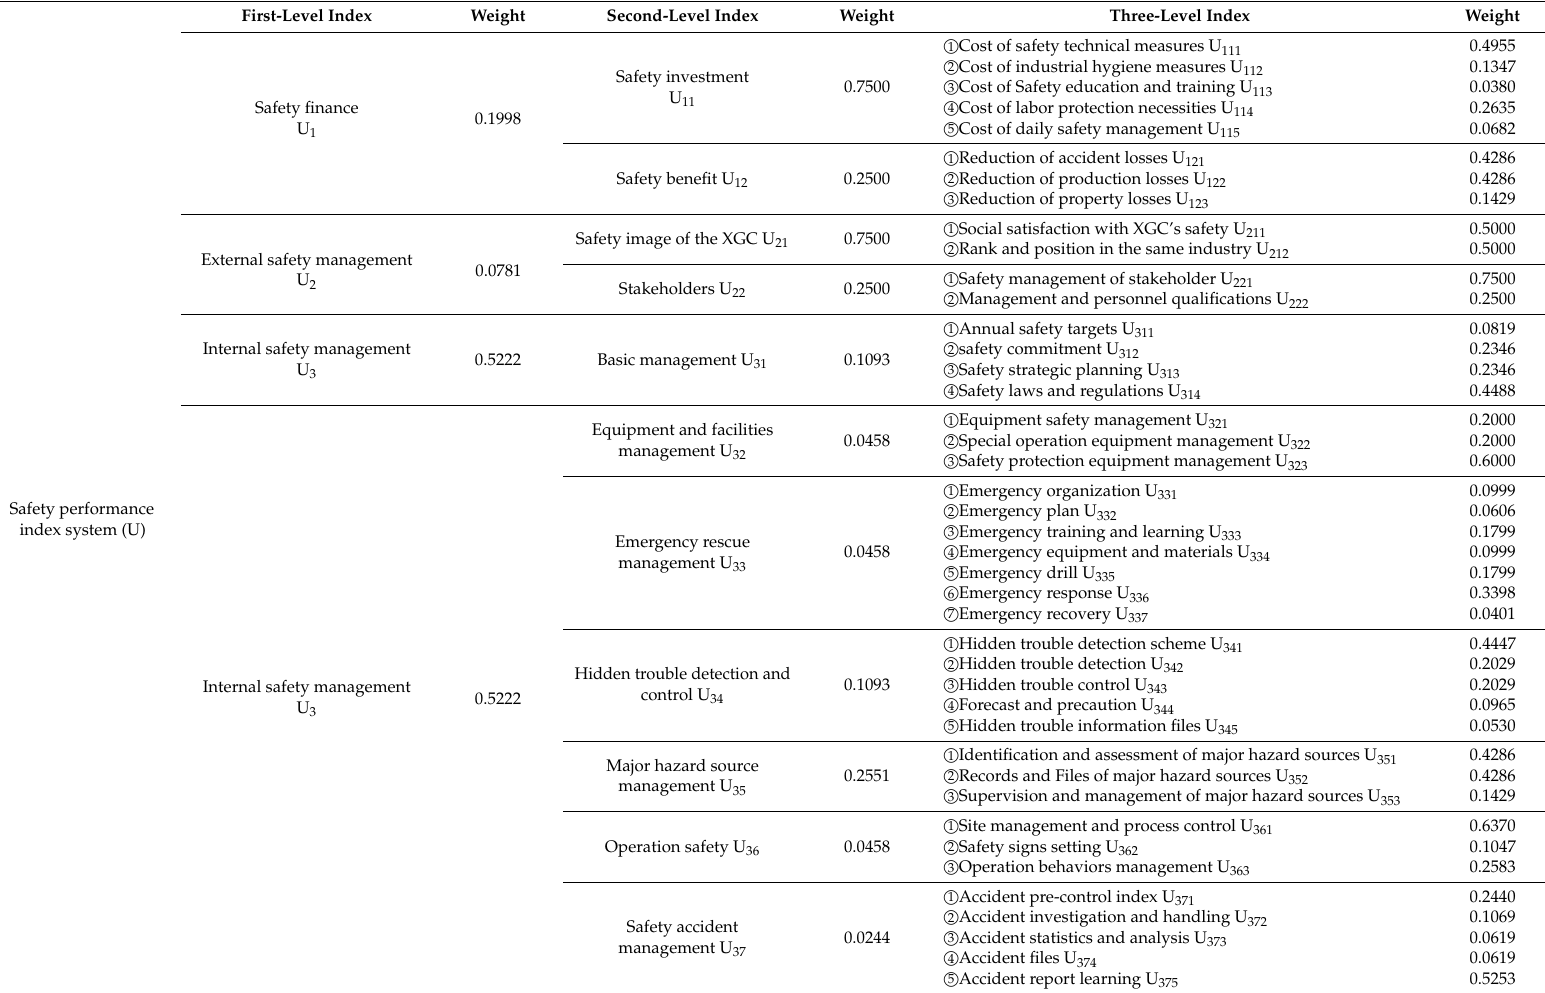
Table 6. Safety performance evaluation index